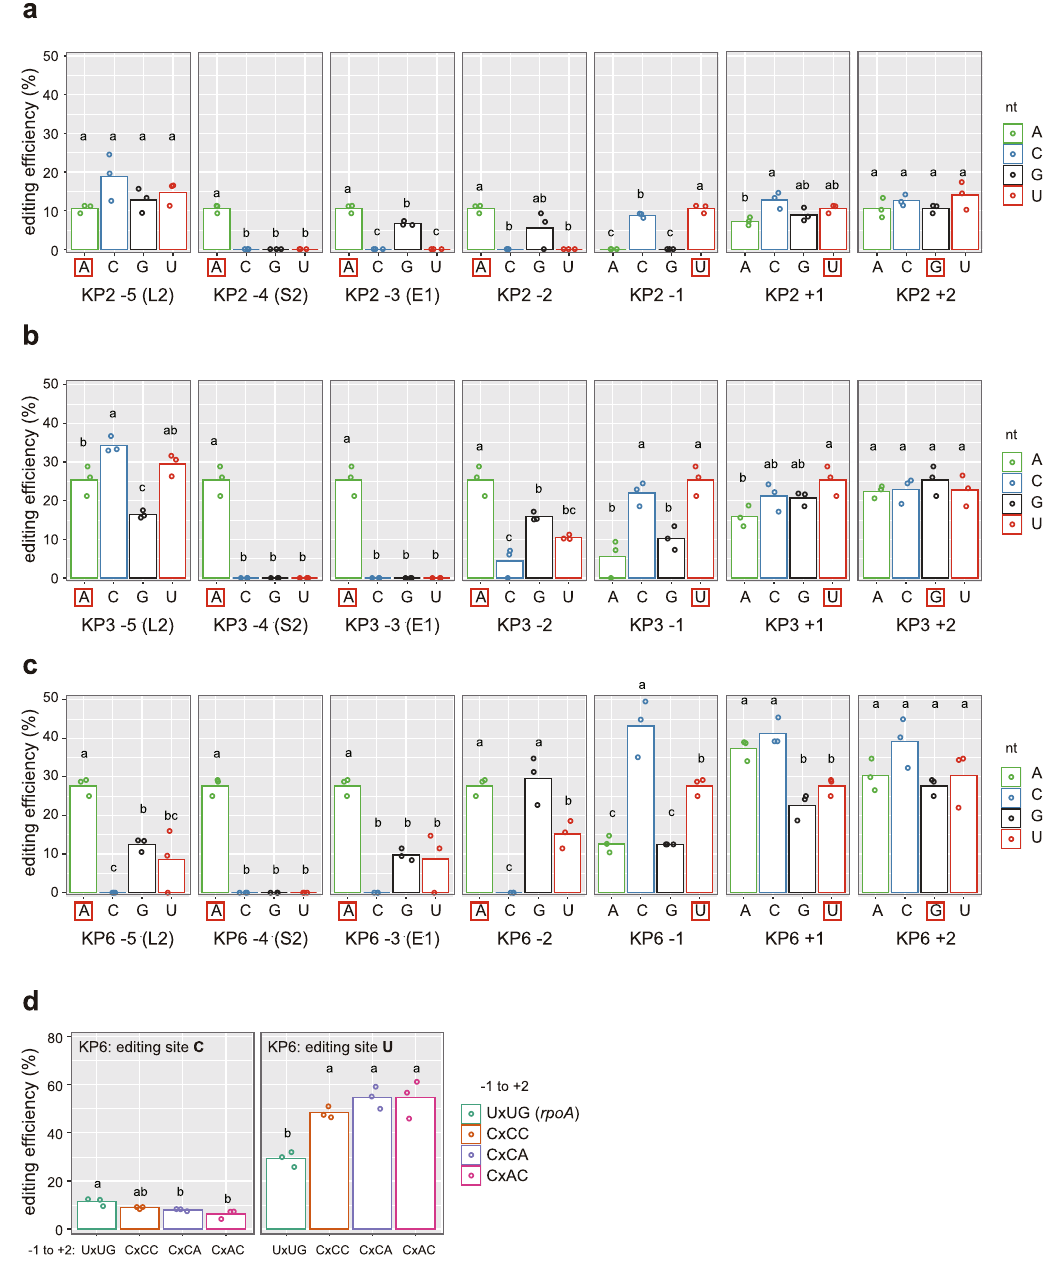
Fig. 5 Designer DYW:KP proteins have a site preference. Nucleotide preference of KP2 ( a ), KP3 ( b ), and KP6 ( c ) around the editing site in HEK293T cells. Positions − 5, − 4, and − 3 are predicted to be recognized by the L2, S2, and E1 motifs. The color code indicates the nucleotides at each position. Red boxes correspond to nucleotides in the original target ( AtrpoA ). d The C-to-U and U-to-C editing ef fi ciencies of KP6 when the target sequence at positions − 1 to + 2 is modi fi ed to follow the nucleotide preference are shown. Dots represent each replicate and bar, the mean of the editing ef fi ciency of the three biologically independent replicates. Signi fi cant differences (one-way ANOVA, Tukey ’ s comparison test, P < 0.05) are indicated with letters, multiple letters indicate that results are not signi fi cantly different for more than one group (e.g., a and b are signi fi cantly different while ab is not signi fi cantly different to a and b